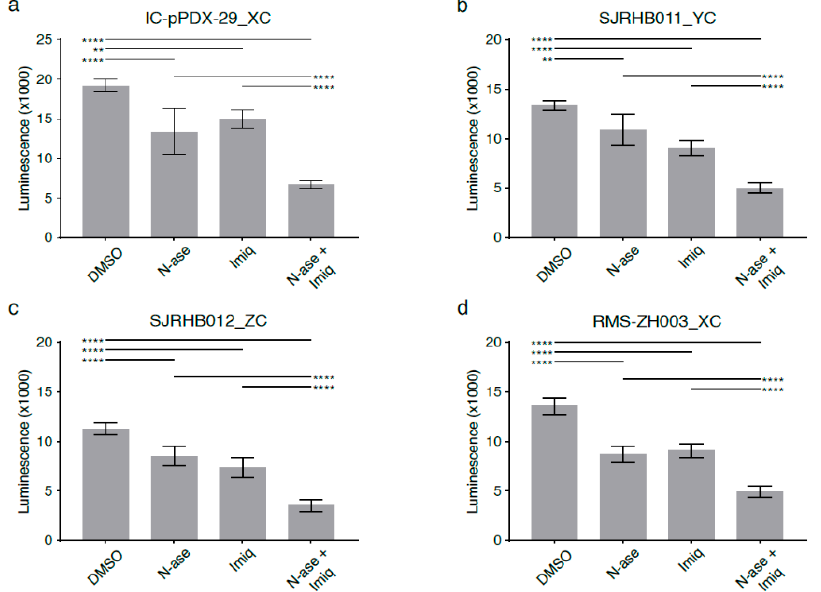
Figure 8. Synergistic growth-inhibitory effects of phenformin and asparaginase on human primary rhabdomyosarcoma cell cultures. Asparaginase and the complex 1 inhibitor imiquimod reduce the proliferation of primary patient-derived human rhabdomyosarcoma cultures ( a ) Ic pPDX-29_XC, ( b ) SJRHB011_YC, ( c ) SJRHB012_ZC and ( d ) RMS-ZH003_XC. ( a – d ) Simultaneous exposure to asparaginase and imiquimod enhances the anti-proliferative effects of both compounds in all four primary rhabdomyosarcoma cell cultures. Data were evaluated for statistical significance by one-way ANOVA with Tukey’s post-hoc test (** p < 0.01, **** p < 0.0001).